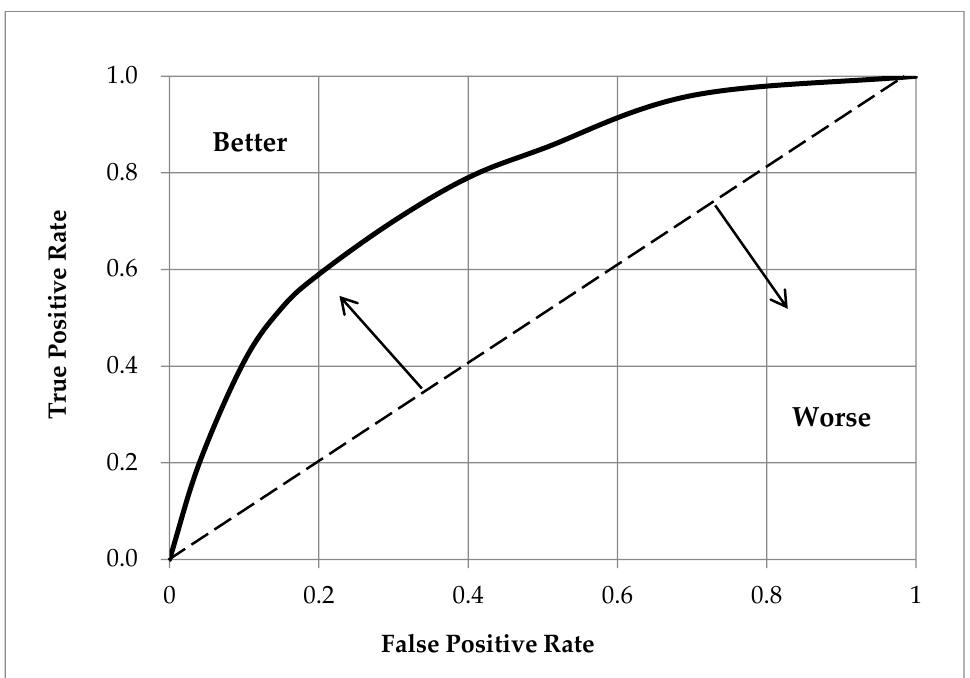
Figure 3. Schematic of a receiver operating characteristic curve as indicative of classification accuracy.